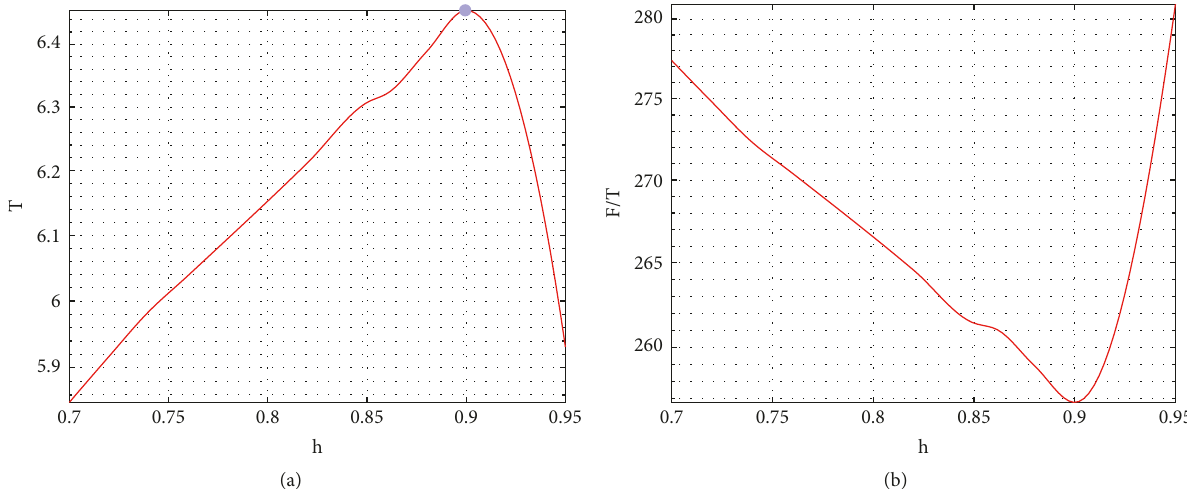
Figure 9: The variety in the period 𝑇 and the profit per unit time 𝐹/𝑇 on the threshold ℎ . (a) The variety in the period 𝑇 on the threshold ℎ . (b) The profits per unit time 𝐹/𝑇 on the threshold ℎ